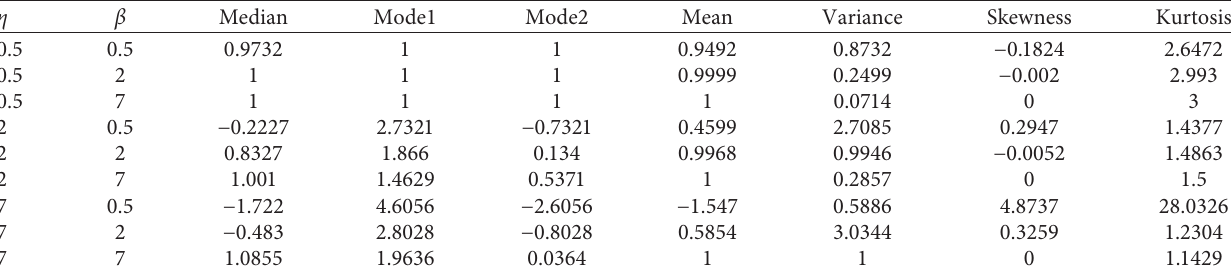
Table 3: Median, Mode, Mean, Variance, Skewness, and Kurtosis of BG Γ